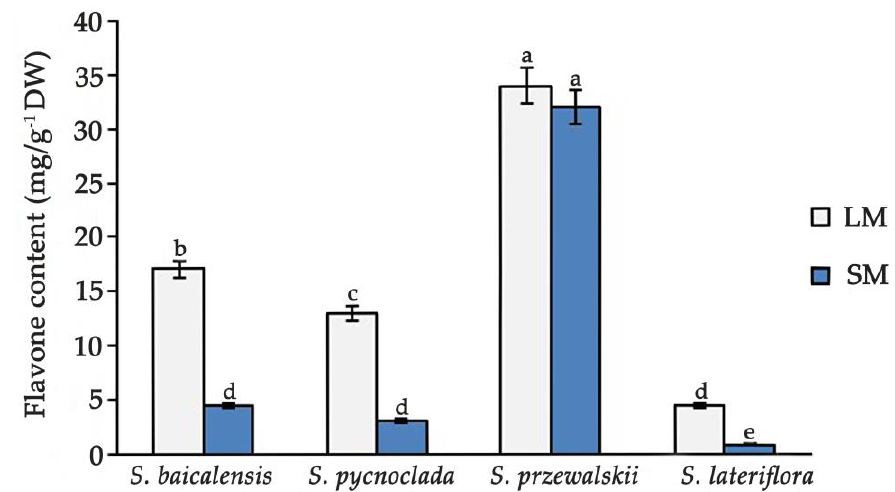
Figure 4. Comparison of the flavones in hairy roots of species of the genus Scutellaria (LM—in liquid medium, SM—on a solid medium). Values are presented as the means ± SD. Different letters indicate a significant difference between the means (one-way ANOVA, p < 0.05).